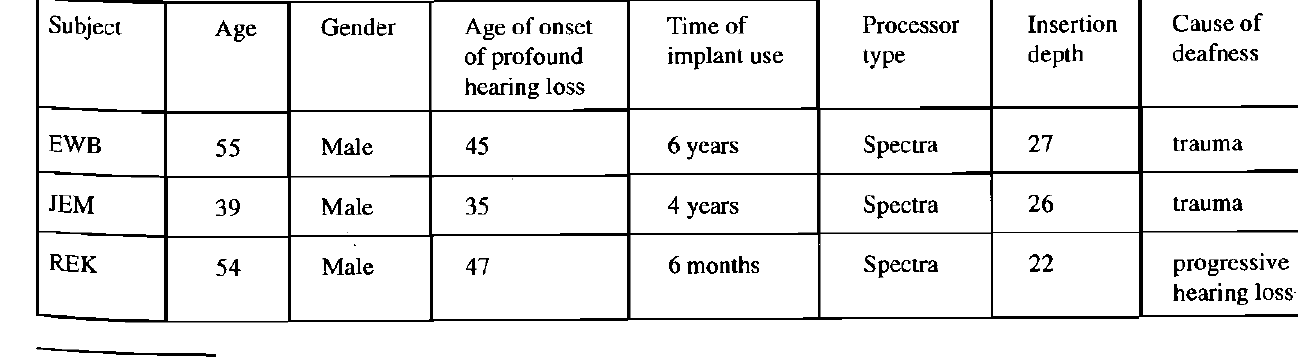
TABLE 1. Subject information for the three subjects who participated in this study. Insertion depth refers to the number of electrode bands inside the cochlea. The first twenty-two electrodes are